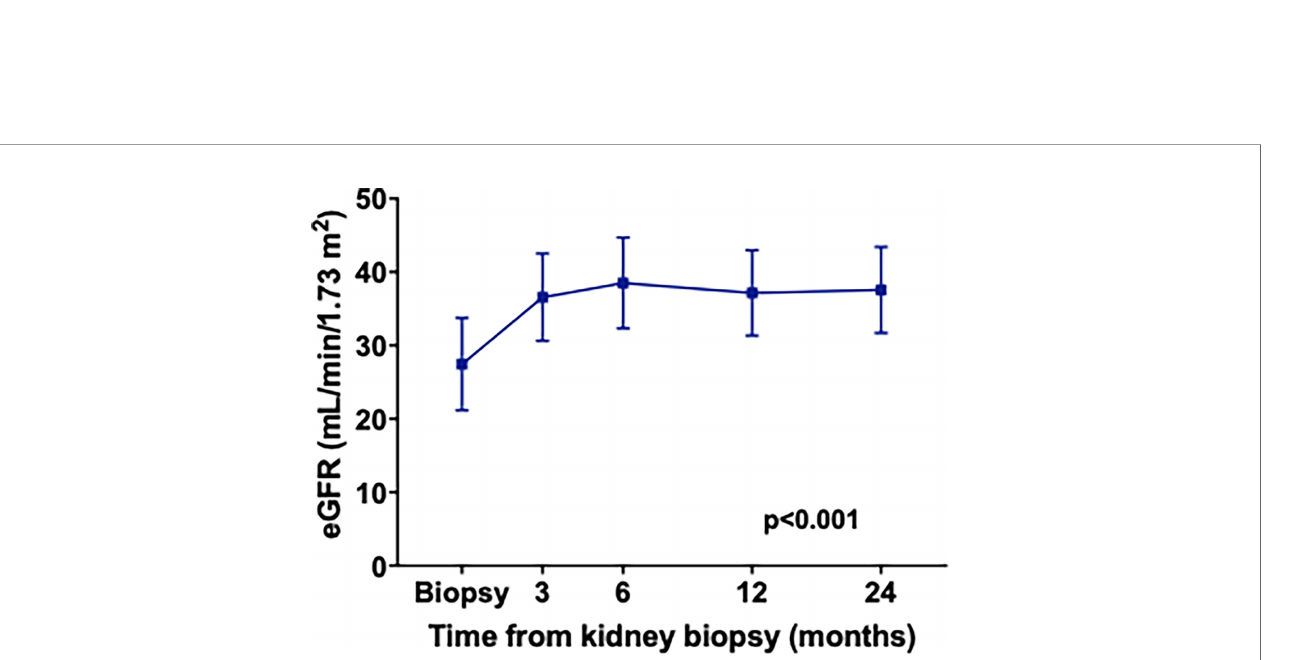
FIGURE 3 | Estimated GFR variation between ANCA-GN diagnosis and month 24 in the eGFR cohort. Statistical analysis was done using a matched one-way ANOVA test.